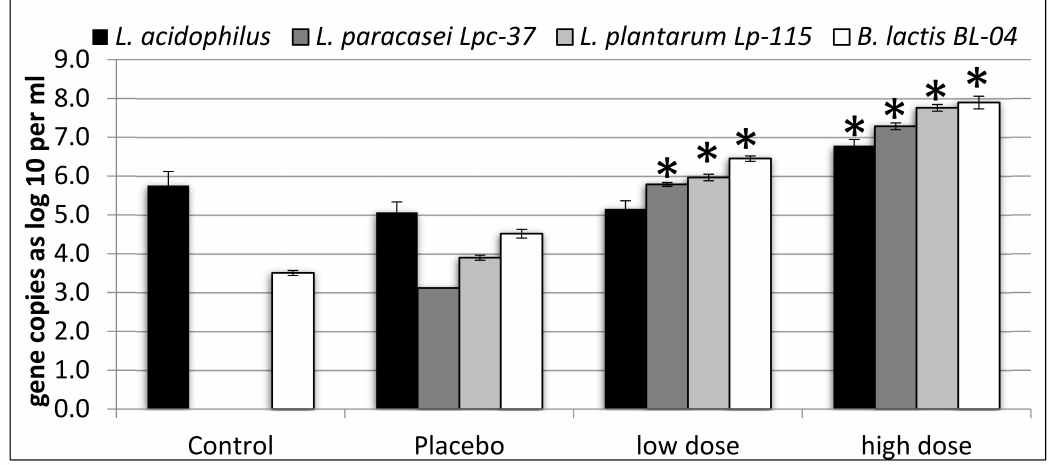
Figure 1. Gene copies of Lactobacillus acidophilus , Lactobacillus paracasei Lpc-37, Lactobacillus plantarum Lp-115, and Bifidobacterium lactis Bl-04 per mL of colonic simulation liquid. Results are expressed as mean and standard error of mean from four simulations, each simulation with fecal material from a di ff erent donor. Asterisks (*) indicate statistically significant ( p < 0.05) di ff erences, as compared with both the control and the placebo.